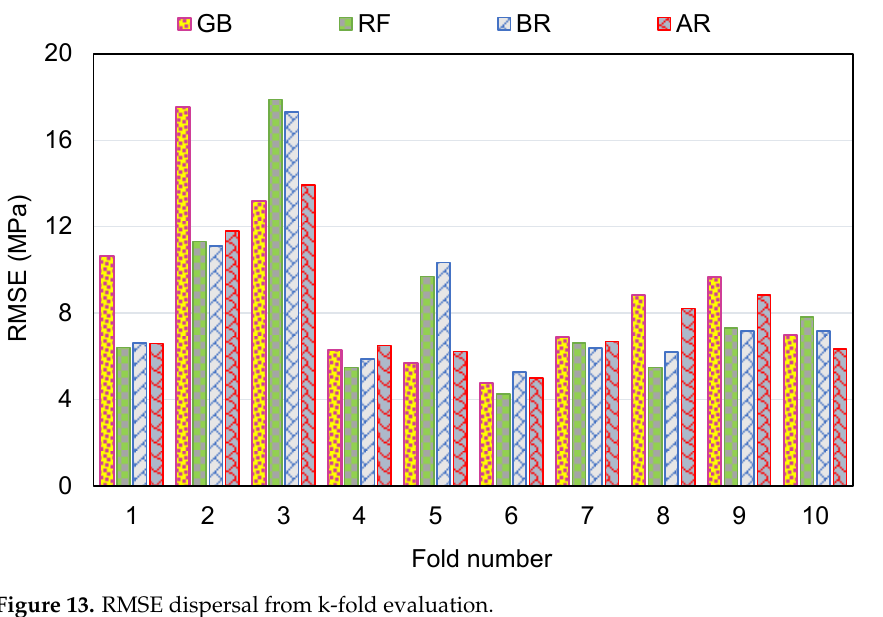
Figure 13. RMSE dispersal from k-fold evaluation.